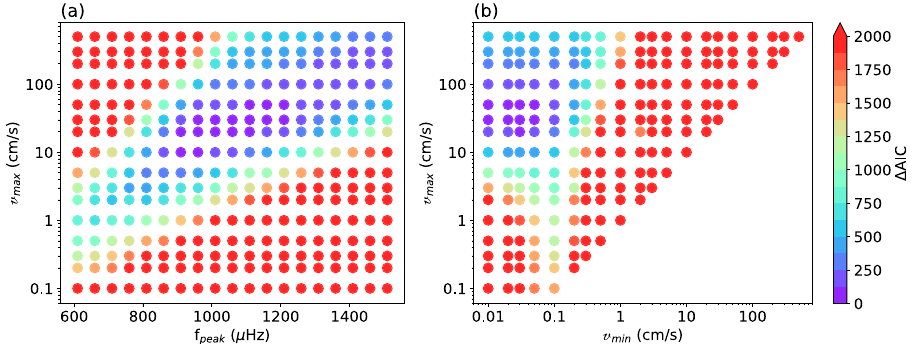
Fig. 3 | Results for two slices of the full parameter space. a Δ AIC value as a function of v max and f peak , with v min =0. b Δ AIC value as a function of v max and v min , with f peak =1200 μ Hz. Both slices have σ f =300 μ Hz. Each circle is a different